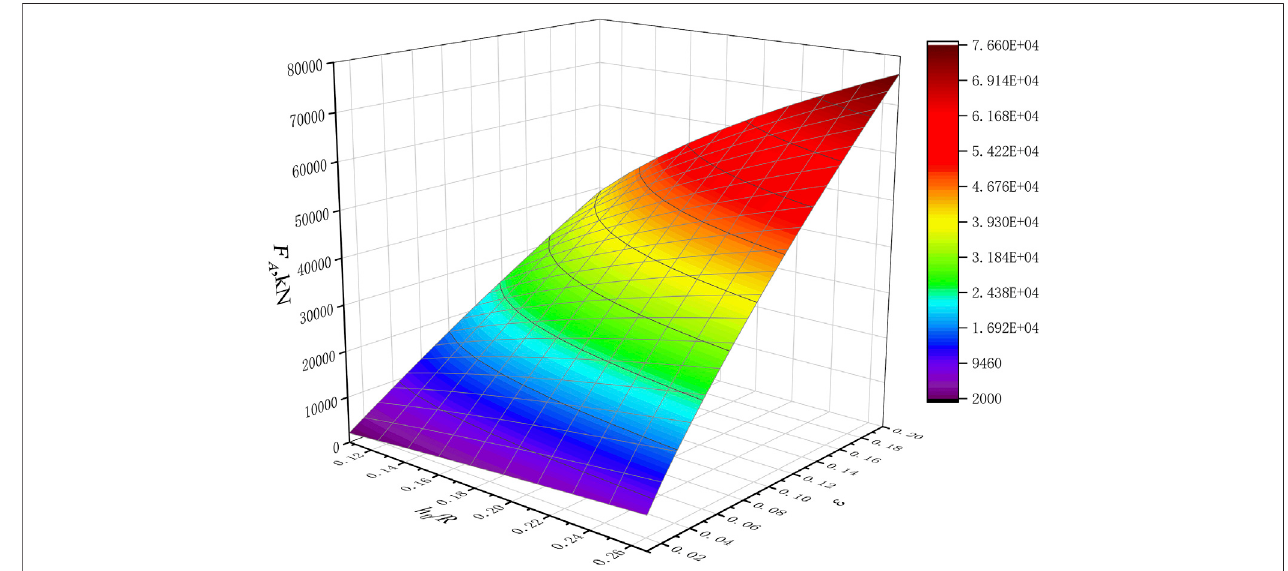
FIGURE 8 | Effect of the thickness to radius ratio and relative reduction on the rolling force.